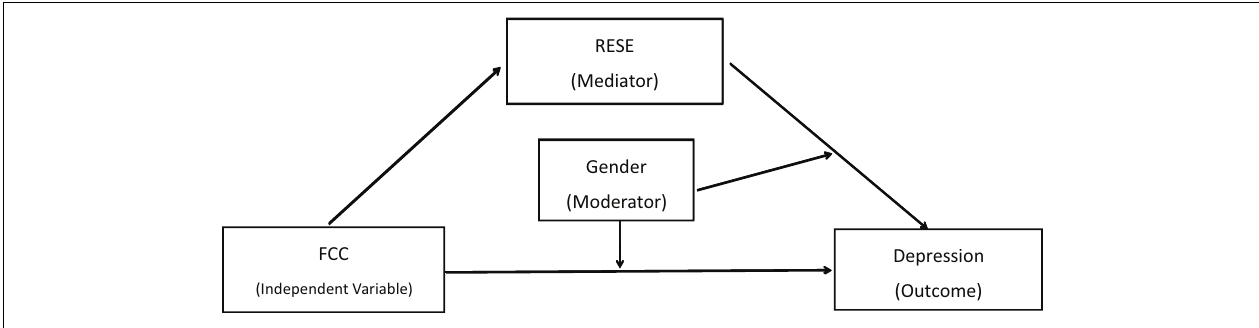
FIGURE 1 | The proposed moderated mediation model. RESE: regulatory emotional self-efficacy; FCC: father-child conflict.